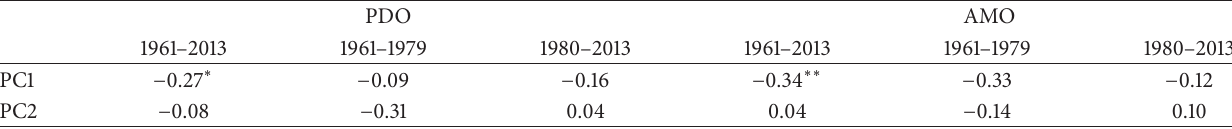
Table 1: The correlation coefficients of the first two principal components with the summer PDO and AMO for the different periods. PDO AMO